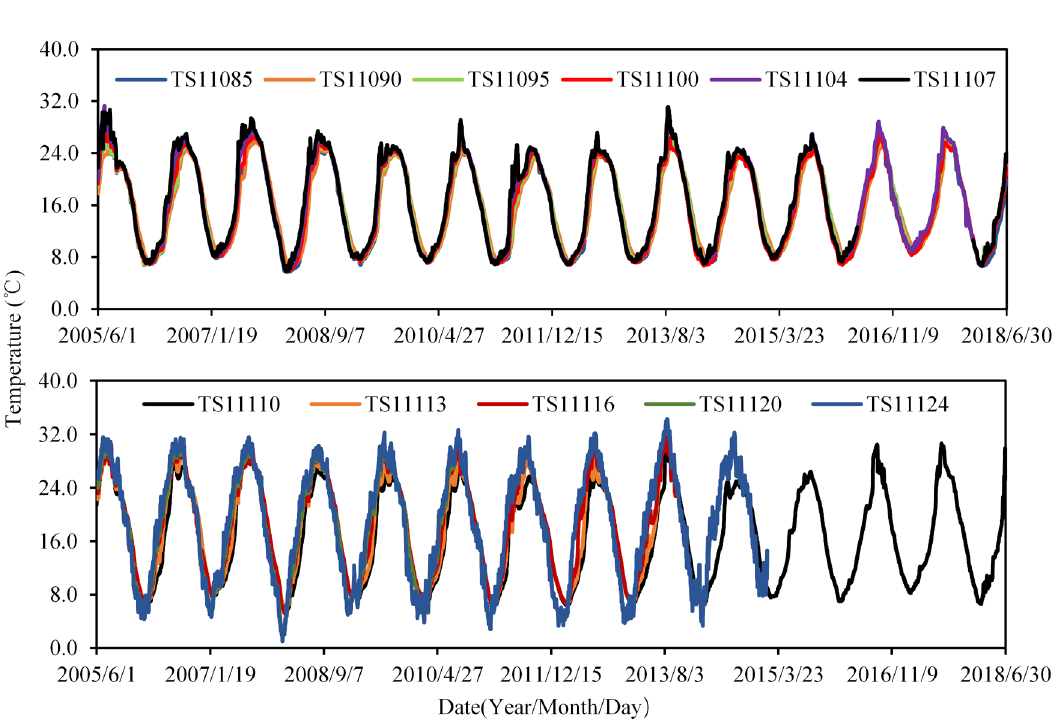
Figure 8. Water temperature at different elevations of Foziling